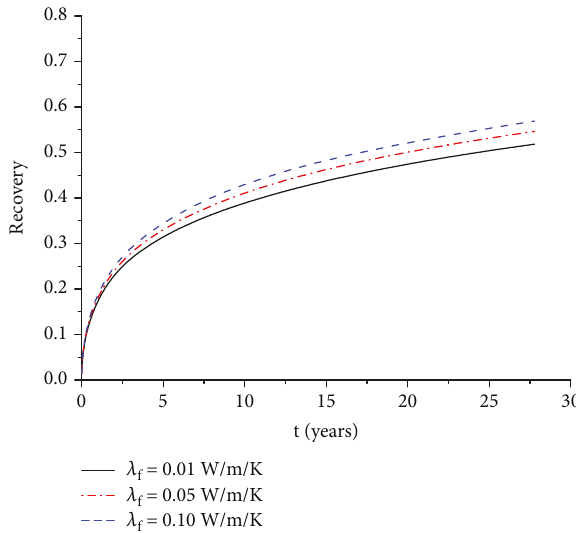
Figure 13: E ff ect of rock thermal conductivity on shale gas recovery.